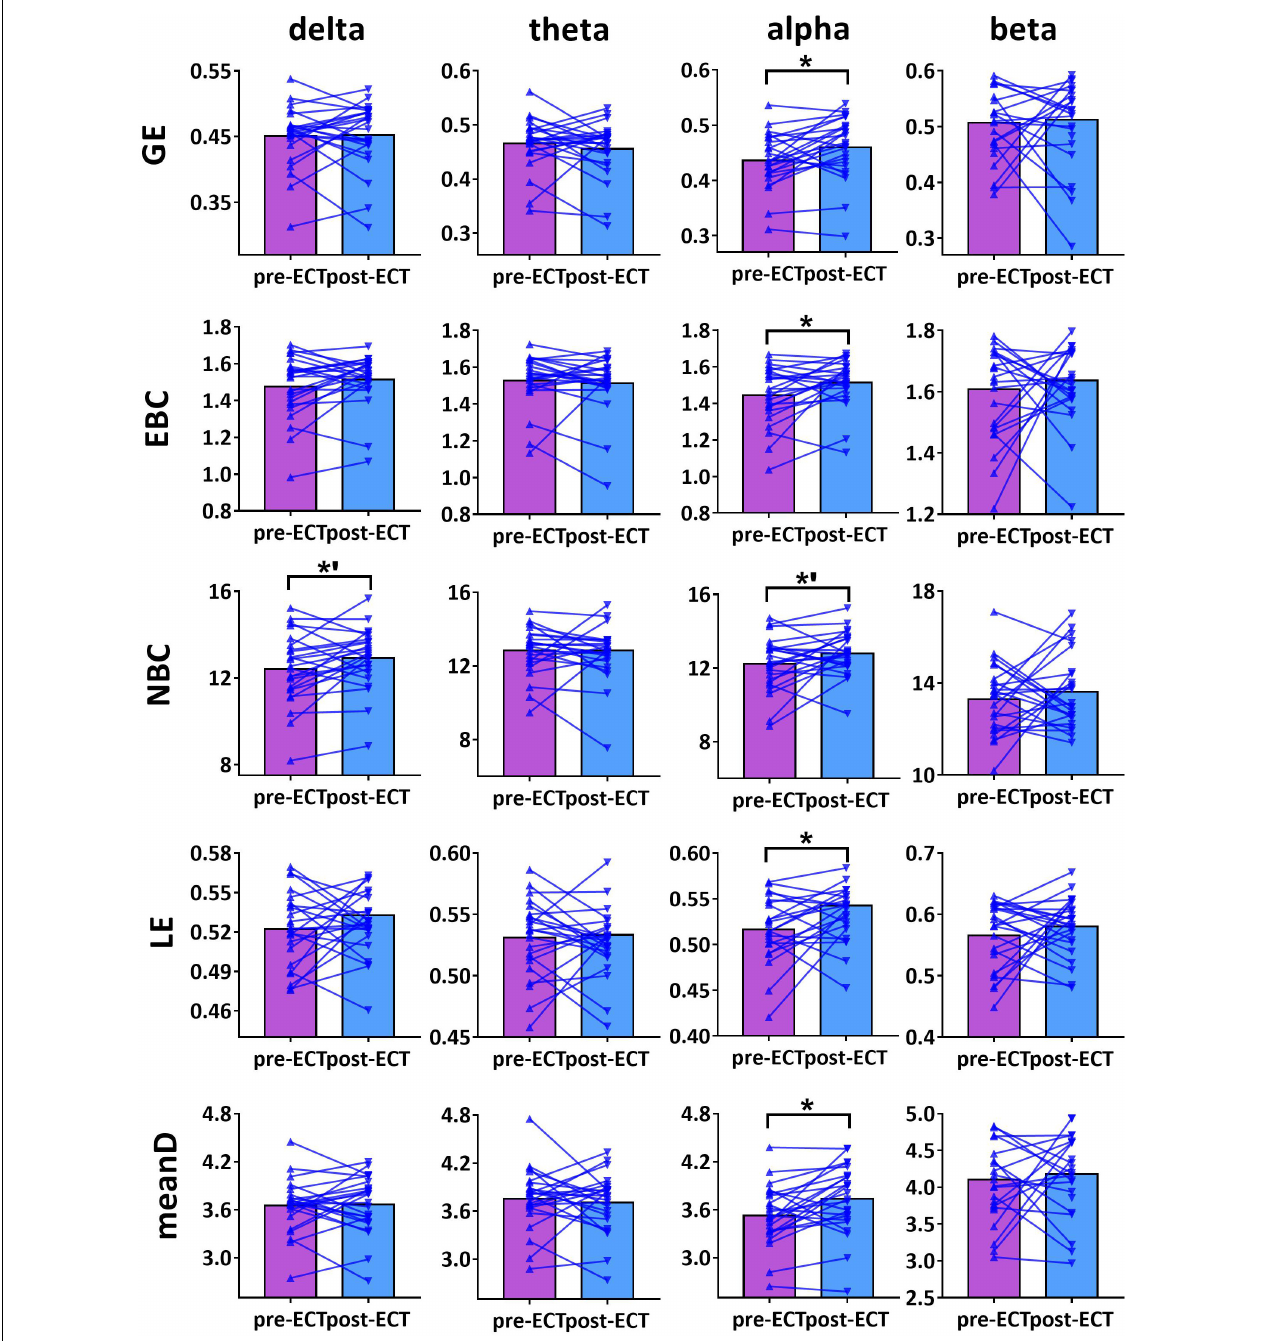
FIGURE 3 | Network metrics of pre- and post-ECT patients with MDD obtained by coupling method Coh and binarization approach Cluster-Span Threshold (CST) in delta, theta, alpha, and beta frequency bands. Network metrics include global efficiency (GE), edge betweenness centrality (EBC), node betweenness centrality (NBC), local efficiency (LE), and mean degree (meanD). The bar chart represents the mean value of network metrics in pre- and post-ECT MDD patients. The * indicates a significant difference ( p < 0.05), the *’ represent marginally significant difference (0.05 < p < 0.1), Pseudo-paired t -test was conducted based on permutation test, n = 10,000, p =